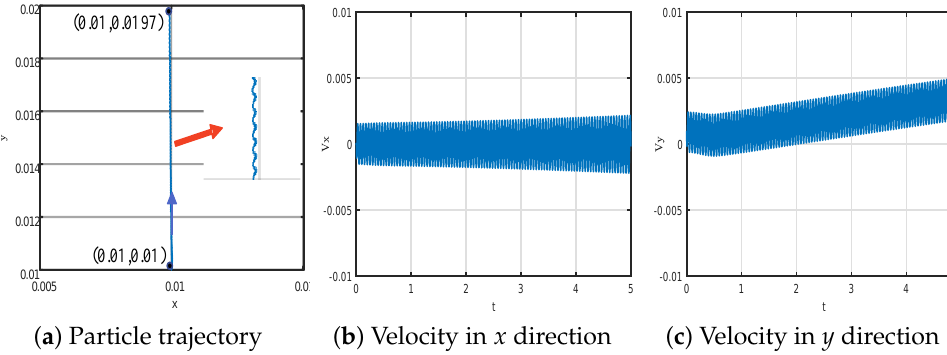
Figure 5. Particle trajectory simulation in sliding region of the first quadrant.